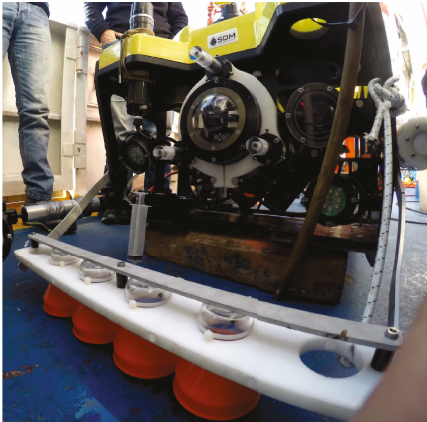
Figure 3: Sampling system for the bubbling gases o ff Zannone (depth in the range of 120-150 m bsl). The ROV was equipped with a homemade sampling system composed of four small funnels connected to 240ml serum-type bottles. The system, fi tted to the front of the ROV, allows to collect bubbles by placing the funnel on the venting gases (see text for more